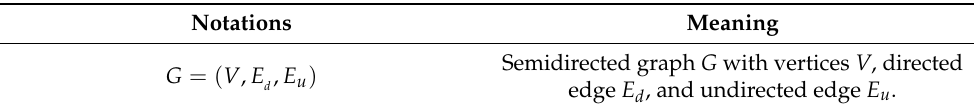
Table 3. Notation and